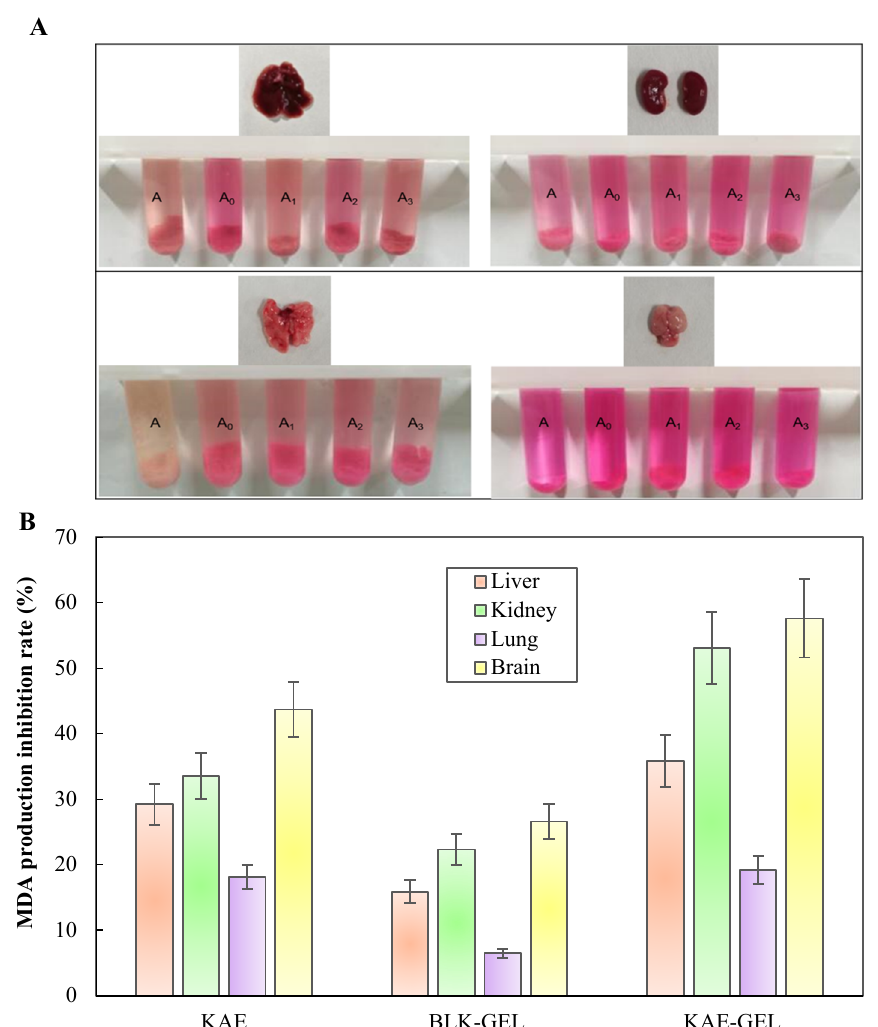
Figure 6. KAE and KAE-GEL inhibited the production of MDA from the tissues of mouse ex vivo. ( A ) Color shows the production of MDA in various tissues. A represents negative control group, A 0 represents positive control group, and A 1-3 represents KAE, BLK-GEL, and KAE-GEL. ( B ) Inhibitory rate of 0.1 mg/mL KAE and KAE-GEL on MDA production in tissues.